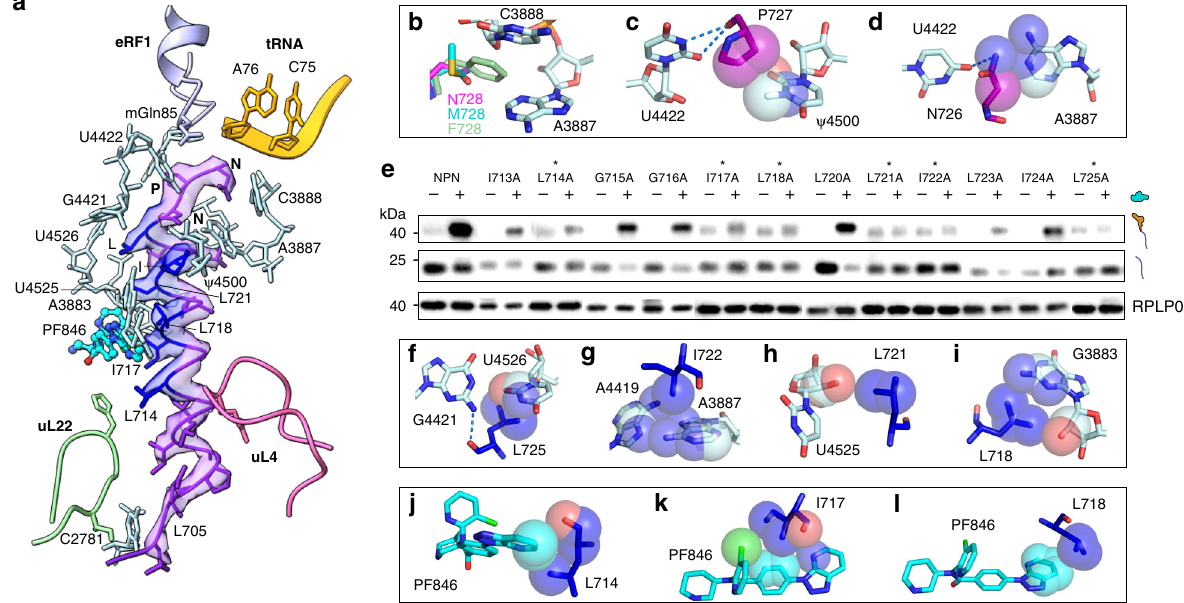
Fig. 3 Structural details of the nascent chain in the nonrotated state and effects of mutations in the NC. a The CDH1 – NPN nascent-chain model within the cryo-EM density (transparent surface). rRNA bases (light cyan) and ribosomal protein residues (light green for uL22 and pink for uL4) that have close interactions with the nascent chain are shown. The amino acids of the nascent chain found to be essential for PF846-mediated stalling are colored blue. Amino acids without numbers are I722, L725, N726, P727, and N728 at the C terminus. b Models of different amino acids at the NC C-terminal position 728. The pocket formed by 28S rRNA nucleotides A3887 and C3888 can accommodate different sizes of amino acid, with methionine (M728) and phenylalanine (F728) as examples. c , d Interactions between P727 and N726 with adjacent 28S rRNA nucleotides. Dashed lines indicate hydrogen bonds and spheres represent van der Waals radii of C, N, and O atoms. e Western blots of FLAG-tagged CDH1 – NPN nascent chains containing single mutations, from in vitro translation reactions in the presence ( + ) or absence ( − ) of 50 μ M PF846. The mutations that affect termination are indicated with asterisks. The positions of tRNA-bound and free nascent chains are shown, with RPLP0 serving as a loading control. f , i Interactions between 28S rRNA nucleotides and the PF846-stalled nascent chain in the nonrotated RNC with dashed lines indicating hydrogen bonds and spheres representing van der Waals radii. j – l Direct interactions between PF846 and nascent-chain residues. Spheres represent van der Waals radii. O, N, and Cl atoms are colored in red, blue, and green, respectively. The experiment shown in e was repeated three times independently with similar